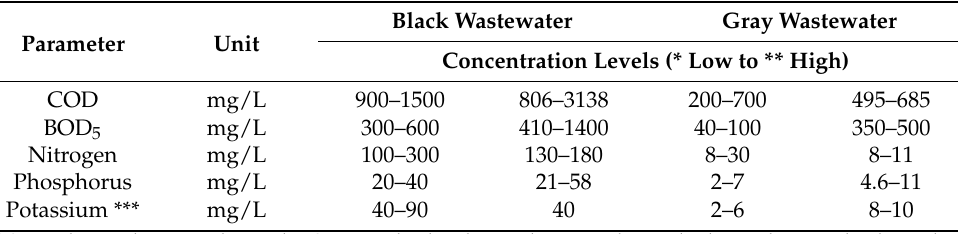
Table 3. Salient characteristics of gray and black wastewater [53,54].